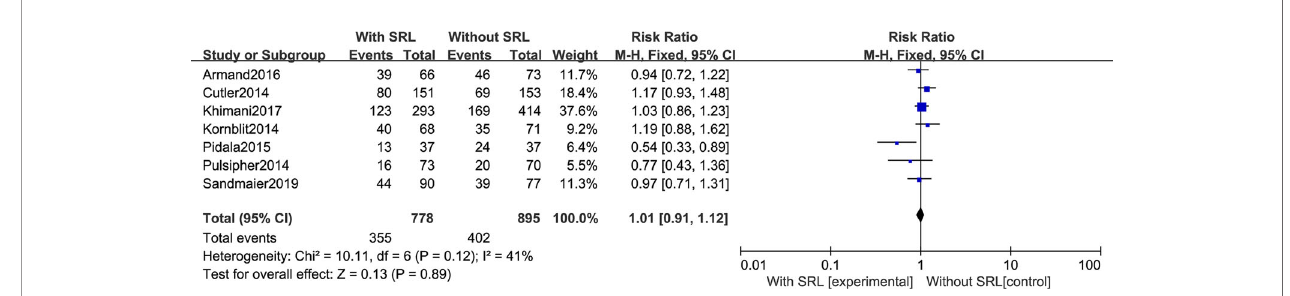
FIGURE 5 | The effect of addition of SRL to prophylaxis on chronic